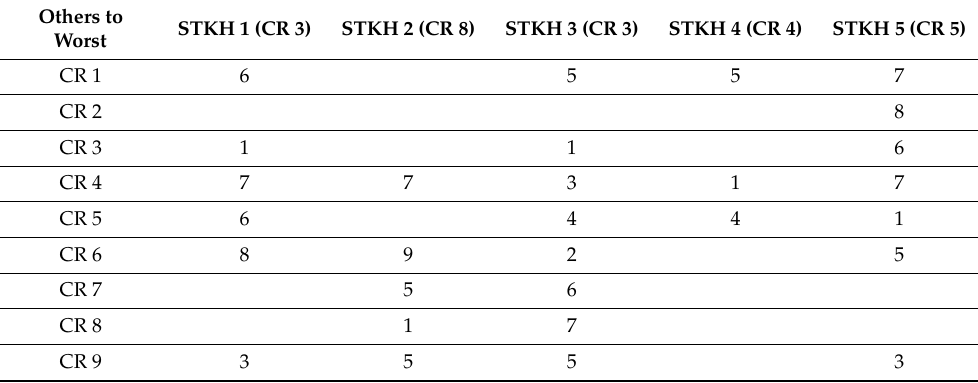
Table A5. Preference values of other criteria over worst criteria by all